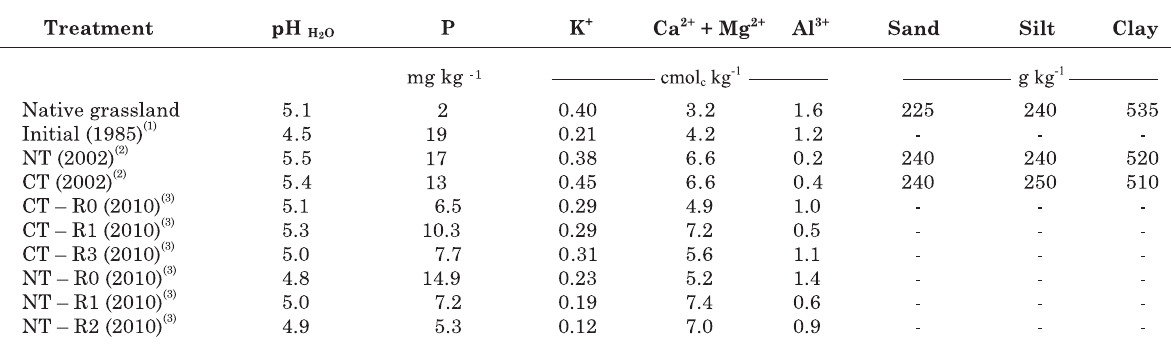
Table 1. Chemical characteristics and particle size distribution of the subtropical Oxisol (0–0.20 m) under native grassland, at the beginning of the experiment in 1985), and after 17 and 25 years under two tillage systems (CT-conventional tillage, and NT- no tillage) and three crop rotations (R0=wheat/soybean; R1=wheat/soybean/ black oat/soybean; R2=black oat/soybean/black oat+common